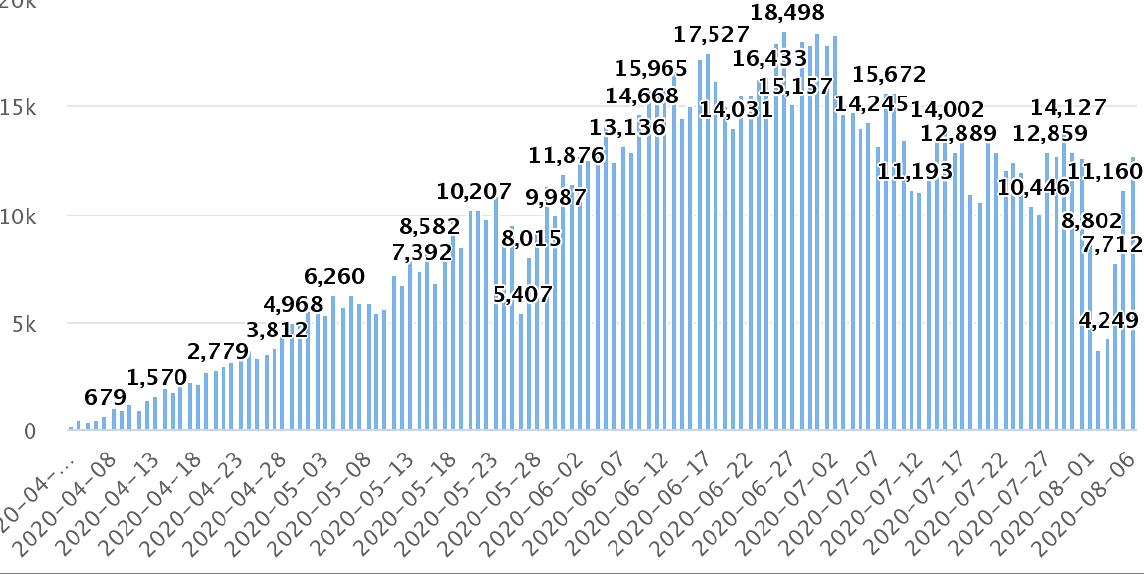
Figure 2. The number of tests performed in Bangladesh from March to August